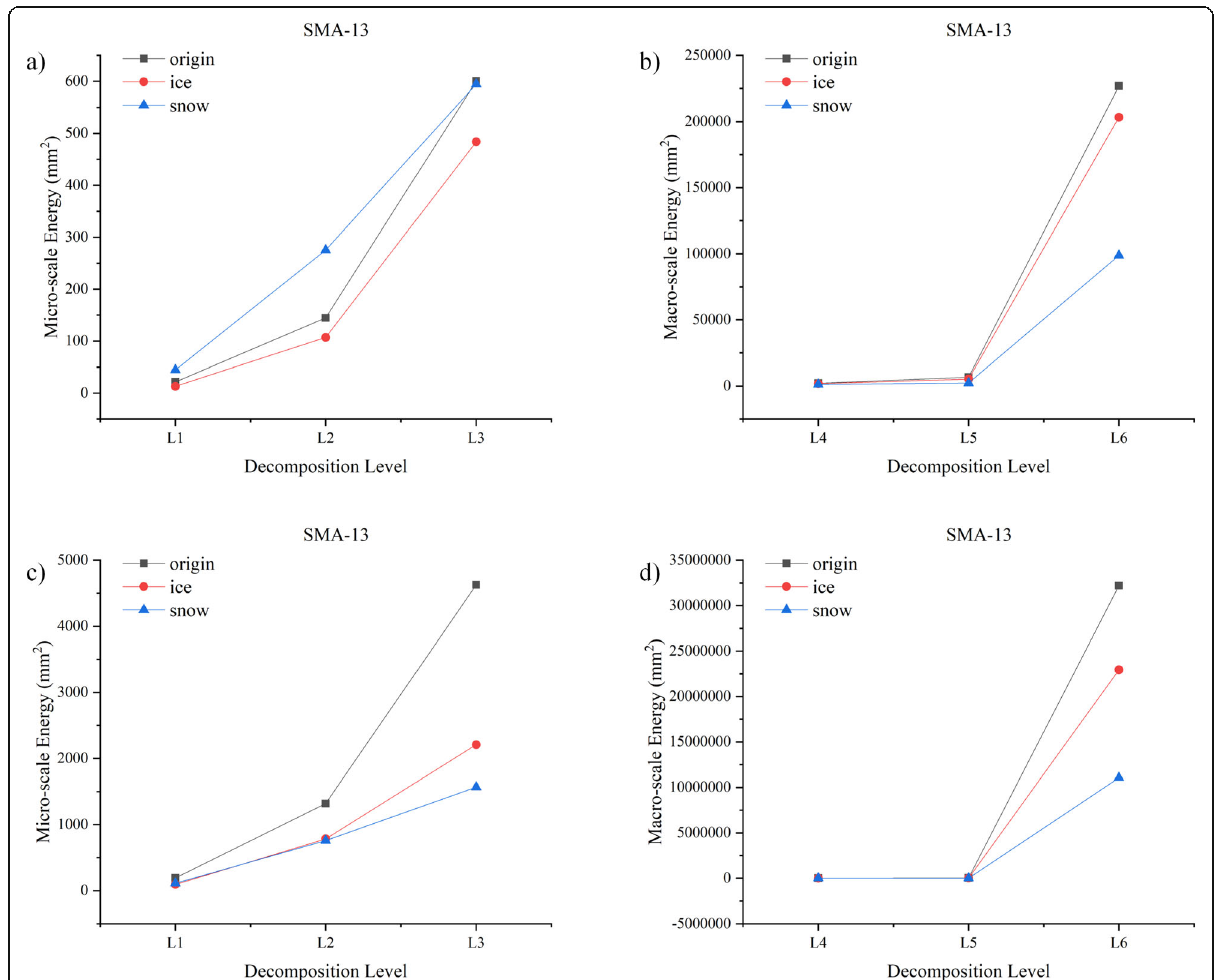
Fig. 10 The Energy Results of SMA-13; a 50% Cutting Plane in micro-scale, b 50% Cutting Plane in macro-scale, c 100% Cutting Plane in micro- scale, d 100% Cutting Plane in